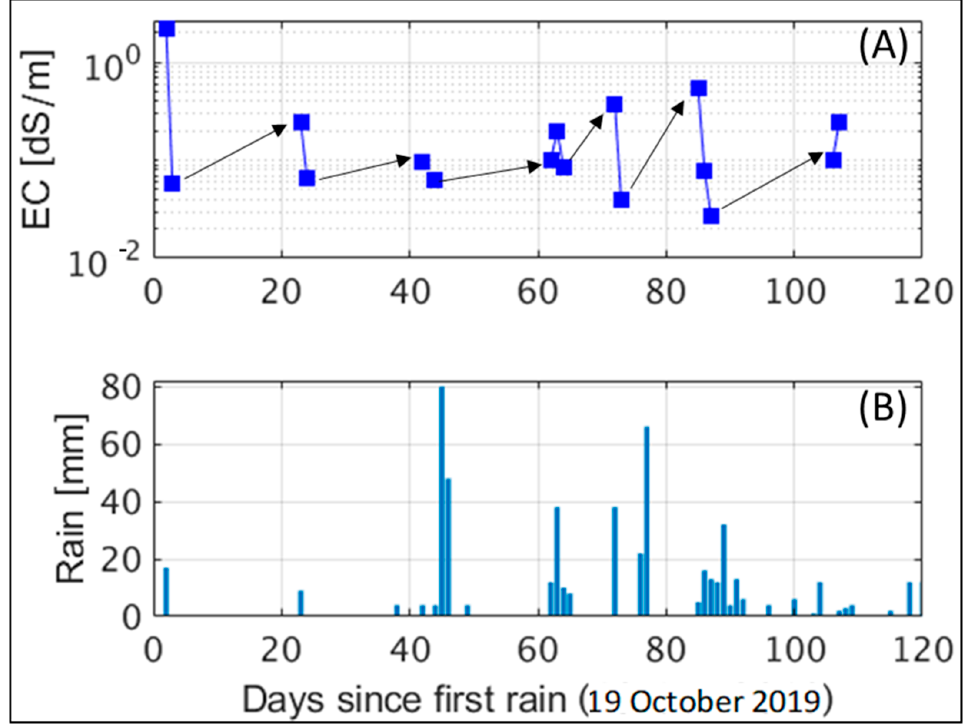
Figure 4. Sampled water EC from roof #1 ( A ), and associated rain depth data ( B ).